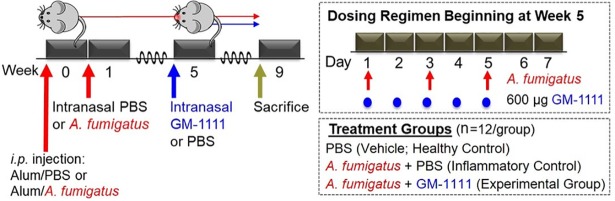
Study design to examine the anti-inflammatory properties of GM-1111 in a murine model of CRS.At week 0, control animals (PBS group) were sensitized with an intraperitoneal (i.p.) injection of PBS vehicle in alum adjuvant, whereas the A. fumigatus + PBS (red arrow) and A. fumigatus + GM-1111 (blue arrow) groups received A. fumigatus extracts in alum adjuvant. After 1 week, the animals were subjected to an 8-week regiment (3 times weekly) of intranasal PBS or A. fumigatus extracts. At week 5, intranasal treatment of GM-1111 or PBS was initiated (5 times weekly) and continued for 4 weeks with continued A. fumigatus extract administration (upper right inset). At week 9, whole blood was collected, and the animals were sacrificed and examined for histologic changes and inflammatory tissue biomarkers associated with CRS.